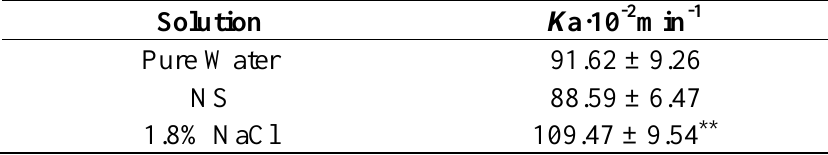
Table 2. K a of paeonol nasal absorption with different osmotic pressures ( n = 5, mean ± S.D.).